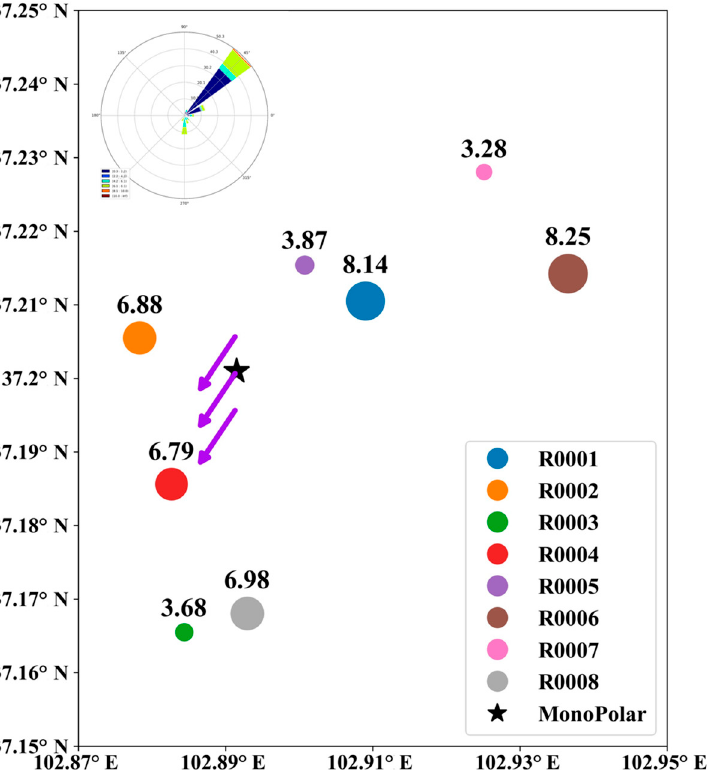
Figure 12. Wind and rain map at power-off in Wushaoling (4 August 2020) The direction of the arrow in the figure indicates the wind direction, and the upper left corner of the figure is the wind rose diagram.